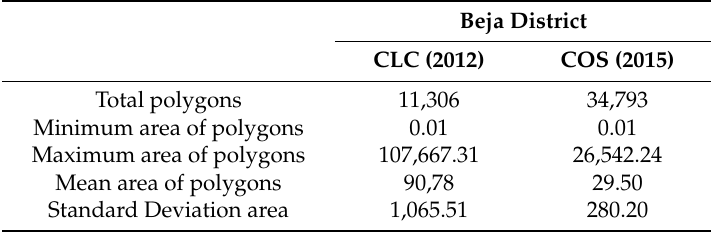
Table 2. Descriptive statistics of reference datasets (area in